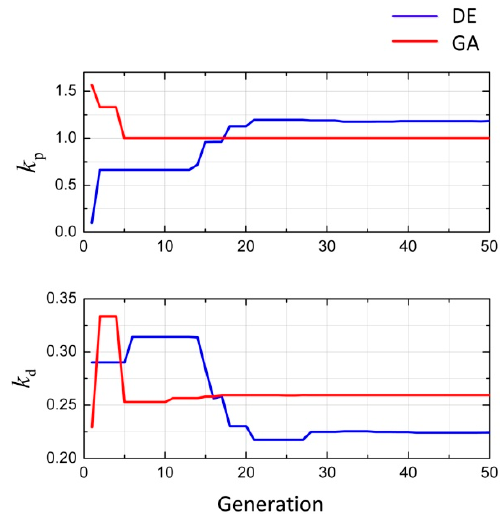
Figure 9. Optimization process of k p and k d in the position tracking experiment.